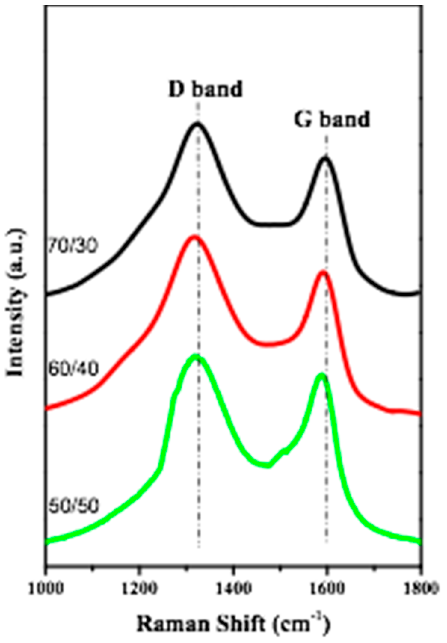
Figure 6. Raman spectra of mesoporous carbons templated by various concentrations of LEL triblock copolymer.